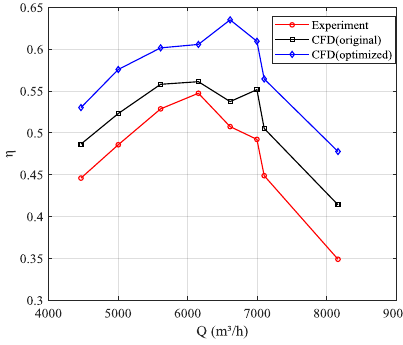
Figure 19. Efficiency comparisons of D500. Figure 19. E ffi ciency comparisons of